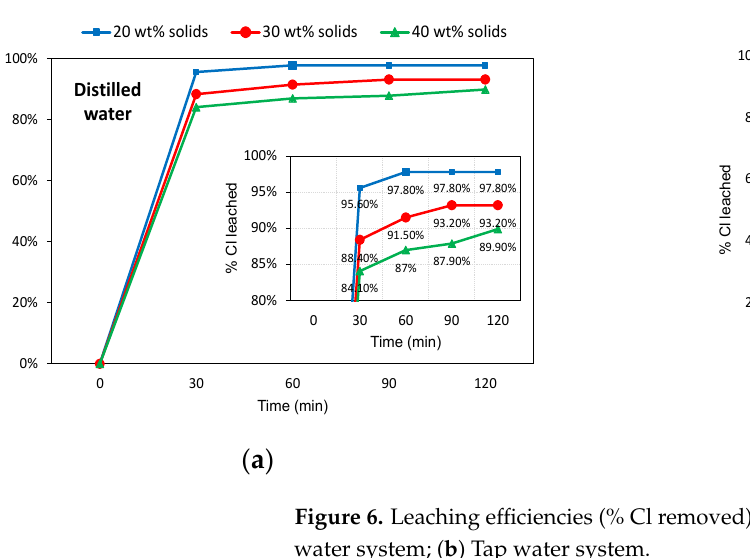
( b ) Figure 6. Leaching e ffi ciencies (% Cl removed) over time for the − 0.5 mm slag samples. ( a ) Distilled water system; ( b ) Tap water system. As pointed out by Graziano et al. [14], provided that the efficient removal of salts is achieved, water consumption during leaching should be minimized to reduce